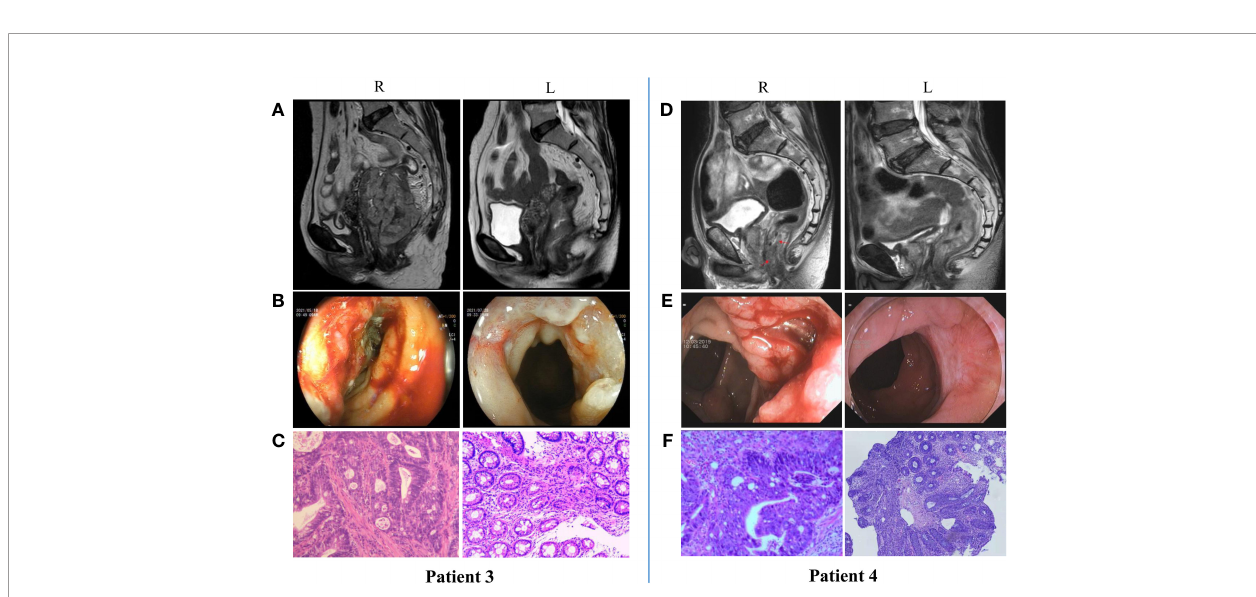
FIGURE 3 | Radiologic, colonoscopic and pathological response to nIT with Tislelizumab in two patients with MSI-H/dMMR LARC (cCR). (A, D) Imaging: Pretreatment (R) VS After 6 cycles of nIT (L); (B, E) Colonoscopy: Pretreatment (R) VS After 6 cycles of nIT with (L); (C, F) Pathology: Pretreatment tumor biospy (R) VS Re-biospy after 6 cycles of nIT